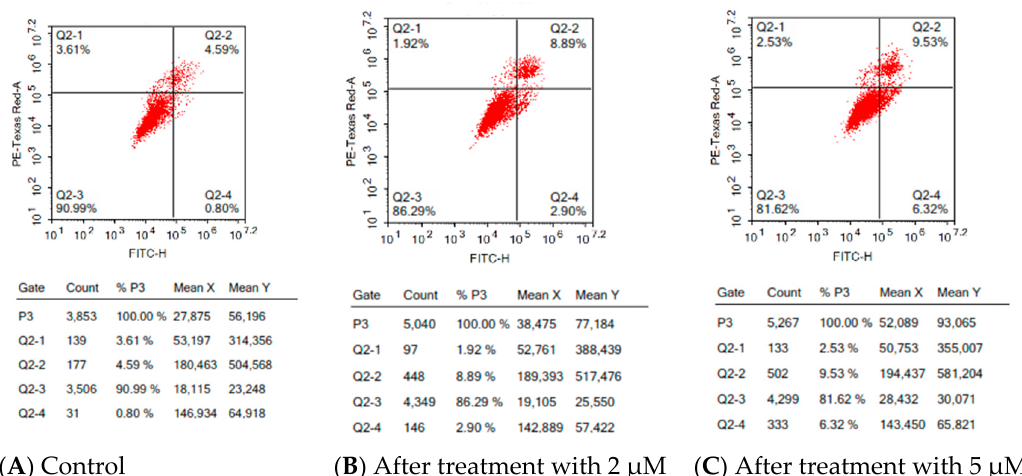
Figure 9. Effects of compound 17a on HepG2 cell apoptosis at ( B ) 2 μ M and ( C ) 5 μ M in comparison to control untreated cells ( A ). The four quadrants are identified as: necrosis phase (Q1), late apoptosis phase (Q2), normal intact cells (Q3) and apoptosis phase (Q4).